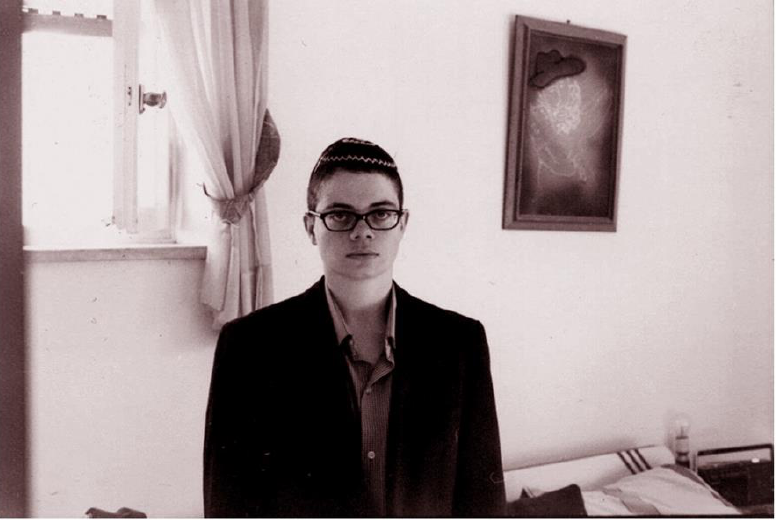
Figure 3. Oreet Ashery, Young Marcus Watching , 1998/ongoing . Photo by Chaya Ashery, artist’s mother. Courtesy of the artist.